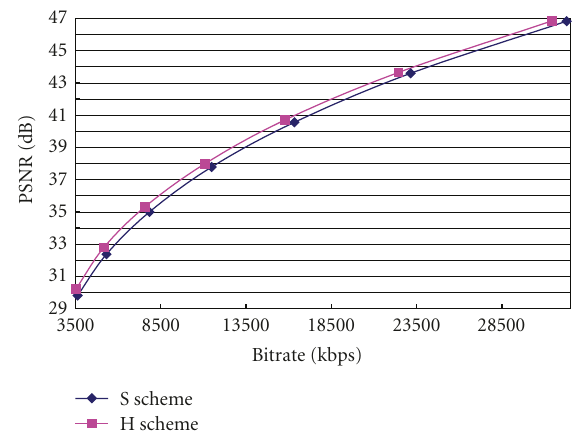
Figure 6: RD curves of encoding Carphone (QCIF) sequence with S scheme and H scheme.